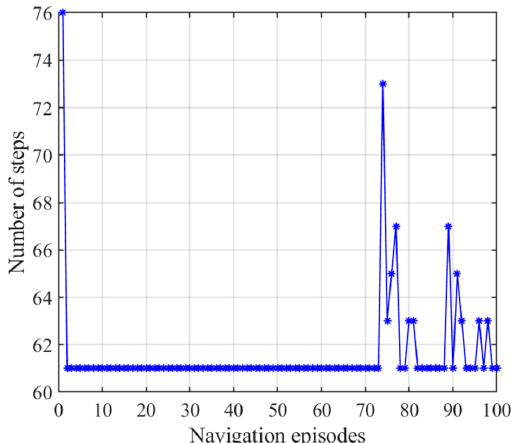
Figure 22. Number of steps with the NLM-HS when door B is closed. Blue asterisks indicate the navigation steps for each navigation episode.